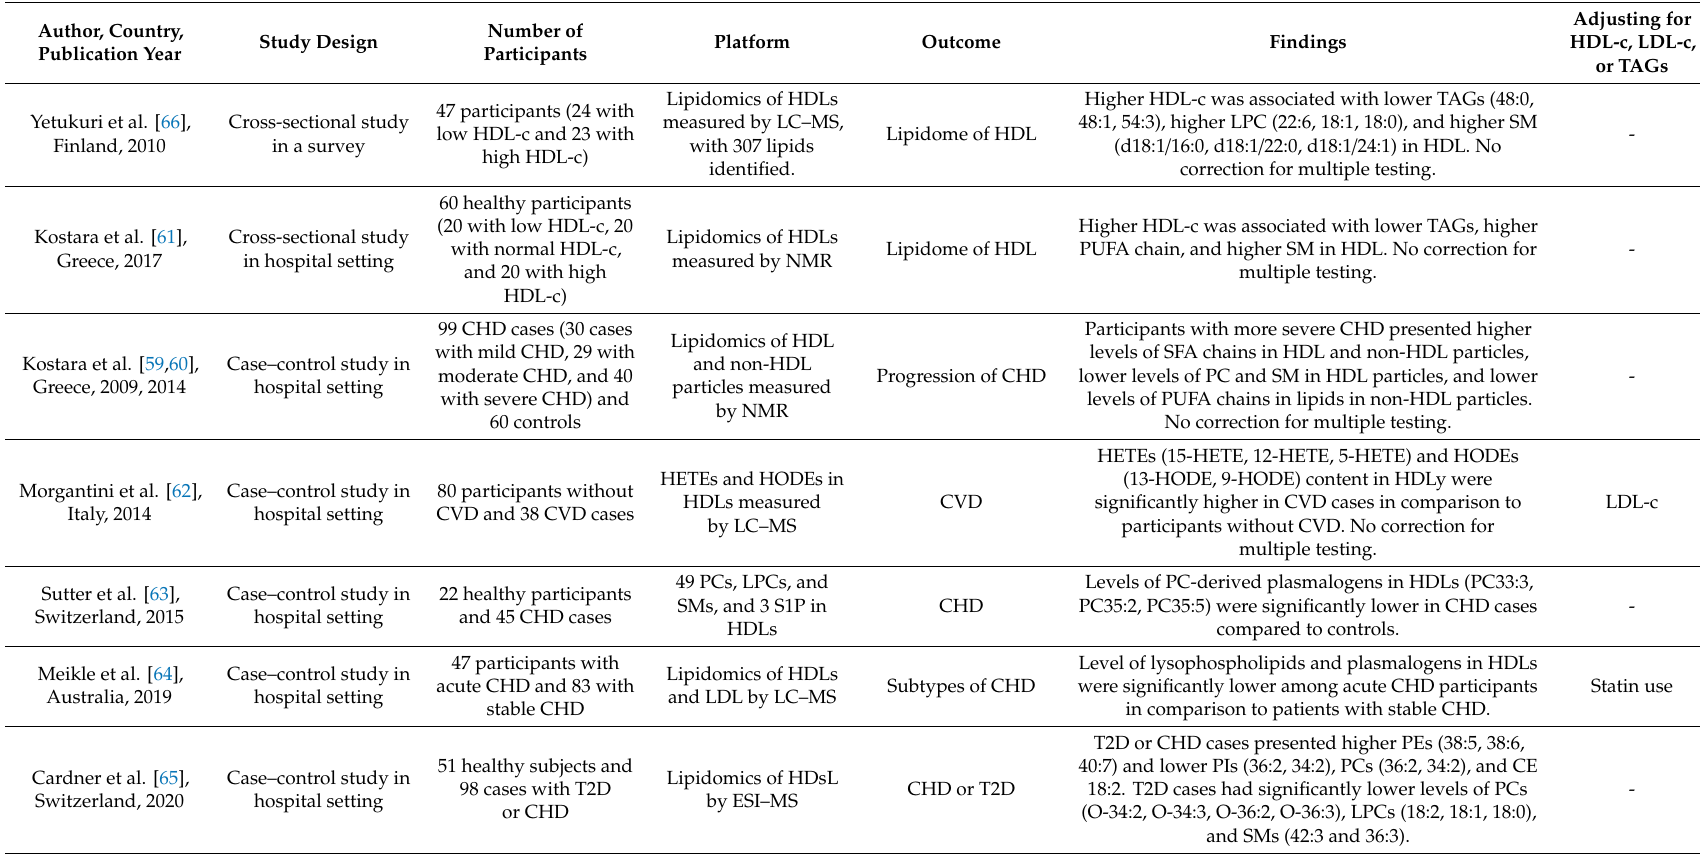
Table 3. A summary of the studies on lipidomics of lipoproteins reporting cardiovascular